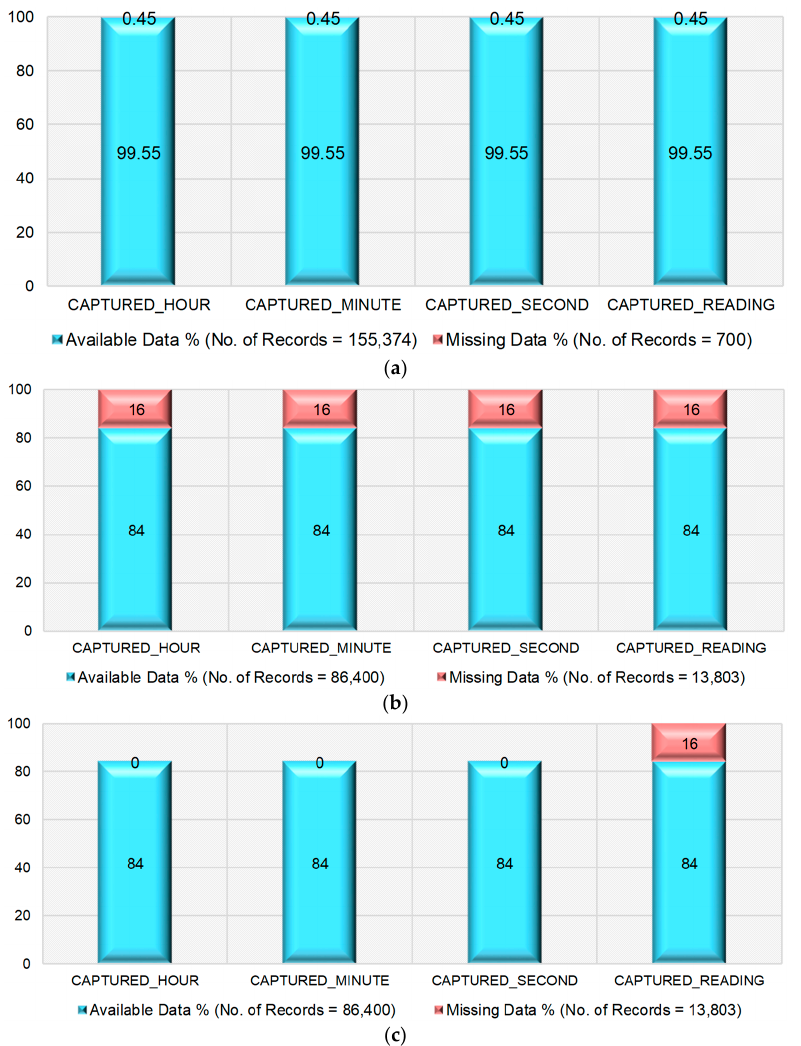
Figure 6. Proportion of missing data in the dataset. ( a ) Original dataset. ( b ) After removing the anomalies. ( c ) After filling missing timestamps.